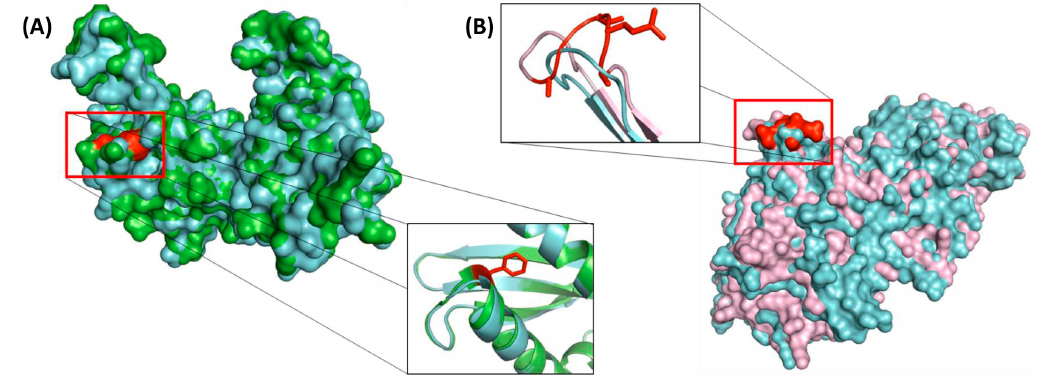
Figure 7. Structural localization of the identified CSIs in two of the studied proteins. ( A ) Structural overlap of a homology model of the 40S ribosomal protein S3 from P. falciparum containing (shown in green) a 1 aa insertion specific for the genus Plasmodium (shown in Figure 4A) with the solved structure of the homologous protein from T. gondii (PDB ascension: 5XXU_D) lacking the CSI (shown in cyan). The CSI in the protein shown in red is present in a surface-exposed loop. ( B ) Structural overlap of a homology model of the protein leucine aminopeptidase from P. vivax containing a 5 aa insertion (see Figure 5D) (shown in pink) with the solved structure of the protein from P. falciparum (PDB ascension: 4ZX8_A) (shown in cyan). The five aa CSI is highlighted in red and it is present on the surface of the protein. As shown in the close up, it extends the length of an existing loop.